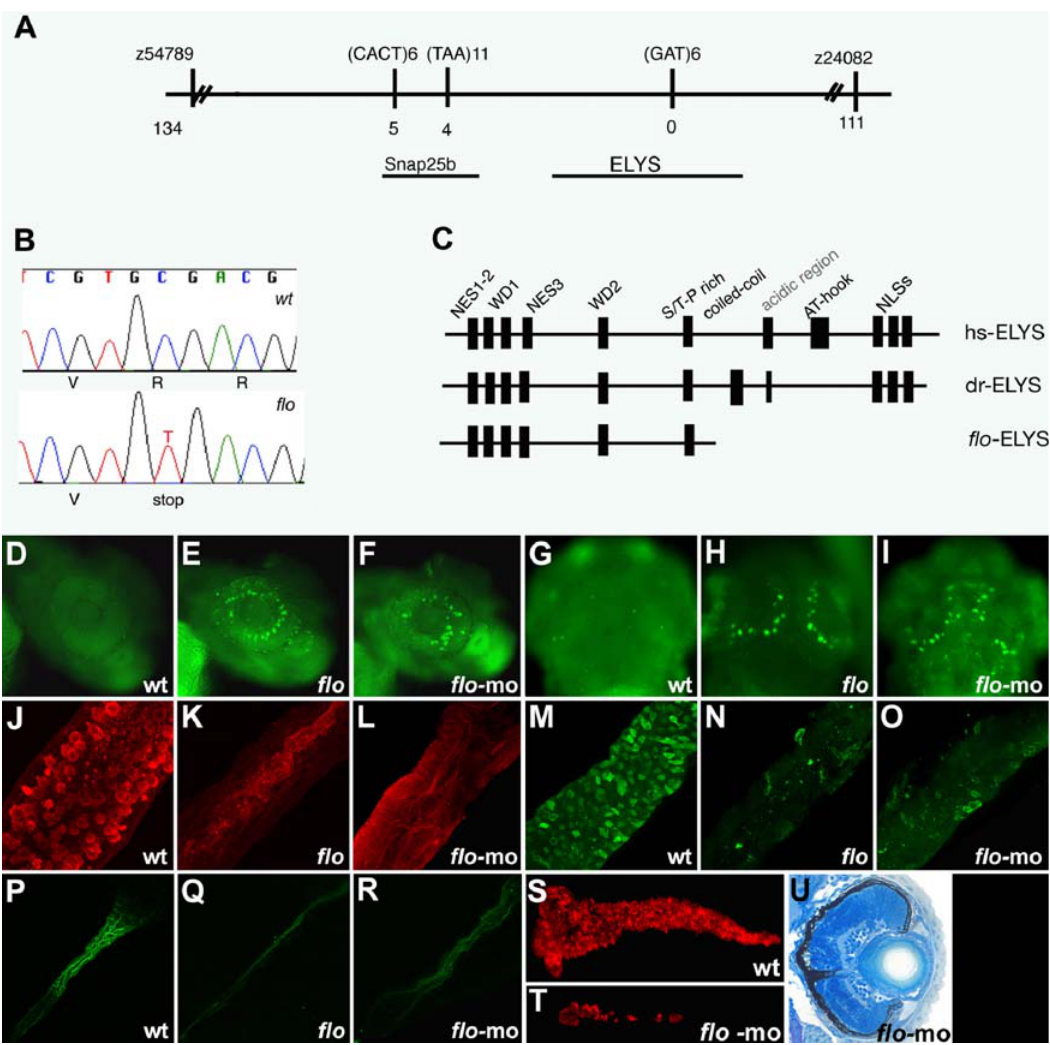
Figure 2. The flo locus encodes zebrafish elys . (A) Schematic representation of the genomic region surrounding the flo locus. The names of the polymorphic markers with the corresponding number of recombinants are listed. (B) DNA sequence analysis showing the cytosine to thymidine transition encoding the premature stop codon in the elys ti262c allele. (C) Schematic representation of the functional domains of the human (hs) and zebrafish (dr) Elys protein and the protein encoded by the elys ti262c allele ( flo- ELYS). (D–I) Acridine orange staining showing apoptotic cells in the retina and growth plate of the optic tectum of 48 hpf flo (E,H) and elys- morpholino injected (F,I) larvae but not wt (D,G). (J–R) Confocal projections through the posterior intestine of 96 hpf larvae showing wheat-germ agglutinin positive goblet cells in the epithelium of the posterior intestine of wt (J) but not flo (K) or elys- morpholino injected (L) larvae; secretory cells in wt (M) but not flo (N) or elys- morpholino (O) injected larvae; enterocytes in wt (P) but not flo (Q) or elys- morpholino (R) injected larvae. (S–T) Carboxy-peptidase A positive cells are abundant in the 5 dpf wt (S) but not in elys- morpholino injected (T) exocrine pancreas. (U) Histological cross section through the retina of a 4 dpf elys morpholino injected larva showing retinal disorganization that is comparable to the 4 dpf flo retina (Figure